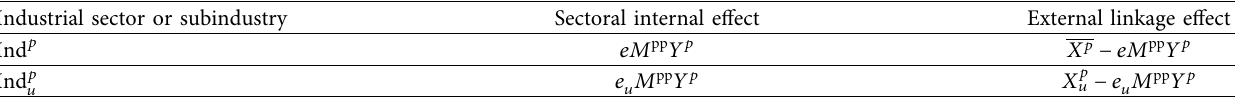
Table 2: The sectoral internal effect and external linkage effect in demand-driven and multisector input-output model. Industrial sector or